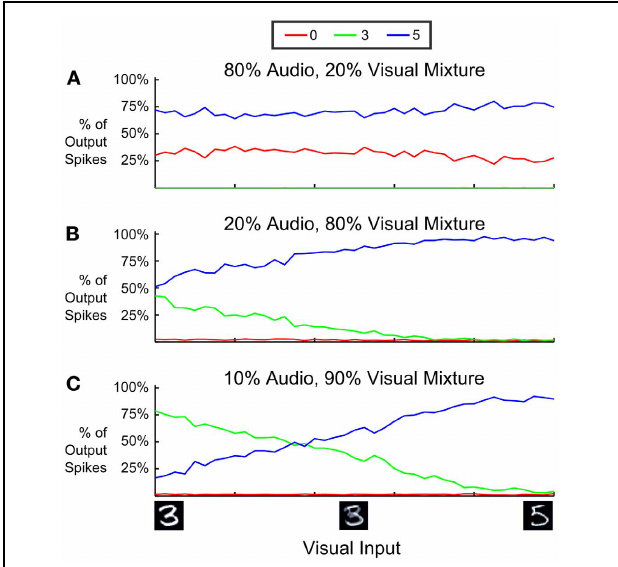
FIGURE 10 | Proportion of output spikes for 3 different mixture ratios of auditory and visual input in a multi-sensory spiking DBN. Red, green, and blue encode the ratio of 0, 3, and 5 choices (spikes) relative to the total number of spikes emitted from the Label Layer (averaged over 10 trials). The horizontal axis sweeps the probability that visual input spikes are chosen from either a “3” digit or an aligned “5” digit. Auditory input consists of a mixture of “0” and “5” inputs, with four times more spikes indicating a “0”. Over a wide range of mixture values, the network correctly infers the only consistent interpretation of the multi-modal input, which is class “5”. Inputs that are inconsistent with the dominating sensory domain (“3” in A , “0” in B,C ) are mostly